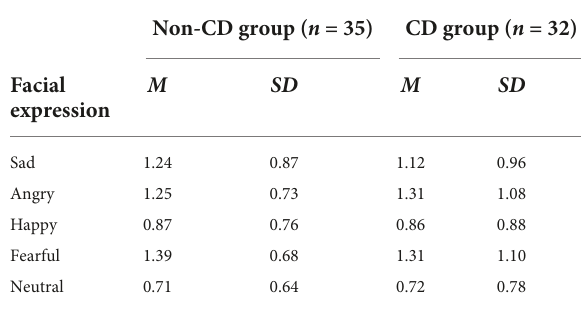
TABLE 5 The average discriminability (d’) in delayed-match-to-sample (DMTS) task.